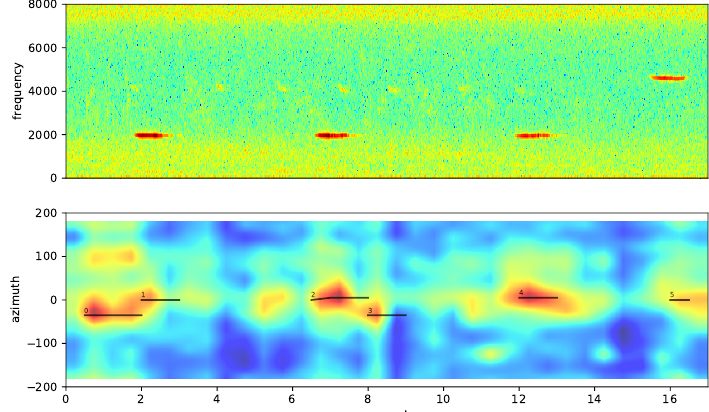
Figure 3. An example of the recording of a replayed sound ( top ) and the localization results ( bottom ). We used the latter part of a replayed sound that include four vocalizations of Scaly Thrush, which is shown in the top figure. The bottom figure shows a heat map of the MUSIC spectrum, whose value represents the strength of sound existence in the corresponding direction. Each black line represents the duration and direction of a localized